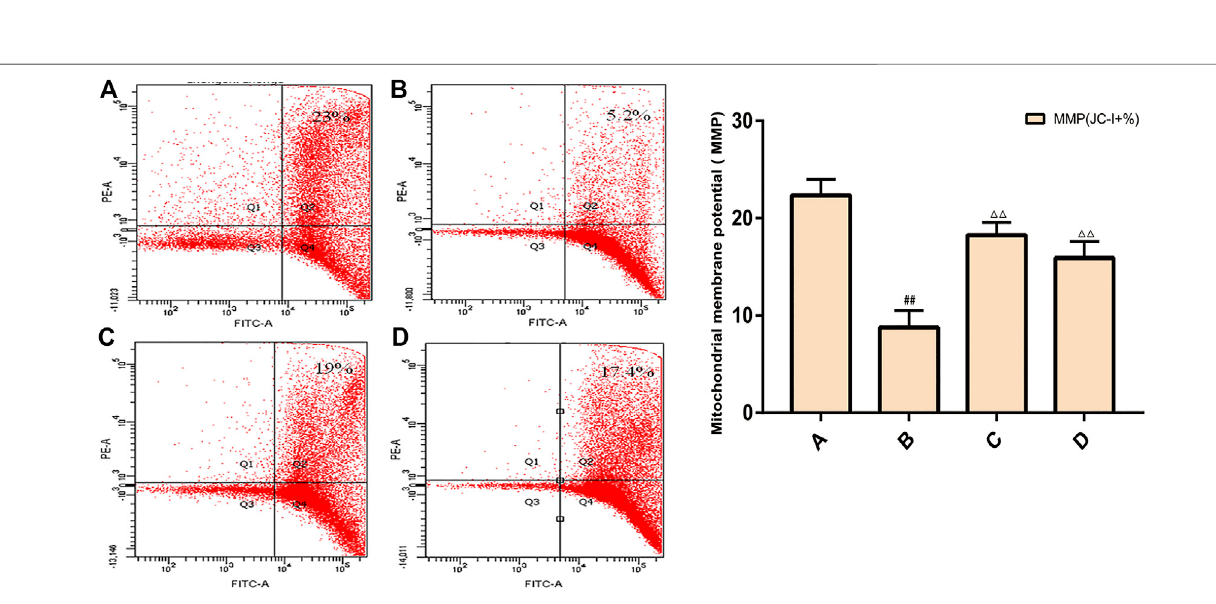
Frontiers in Pharmacology |